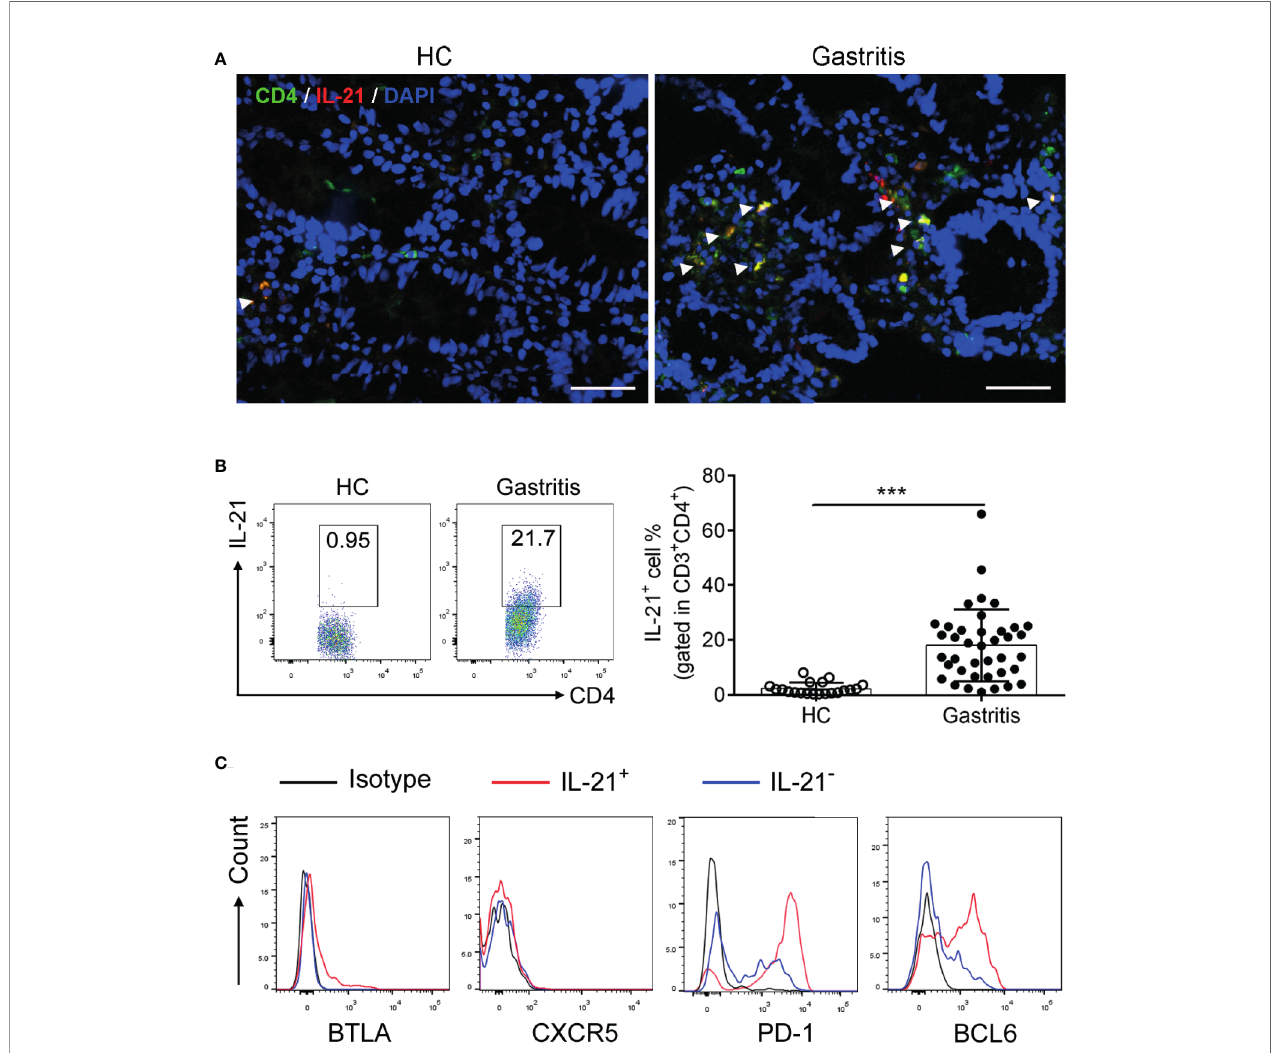
FIGURE 1 | Identi fi cation of IL-21 + TFH-like cells in Helicobacter pylori -positive gastritis. The biopsy specimens of gastric mucosa from H. pylori -positive patients ( n = 39) and healthy controls ( n = 20) were collected. (A) Immuno fl uorescence was conducted to determine the co-localization of CD4 (green) with IL-21 (red). The nucleus was stained with DAPI (blue). Scale bar: 100 µm. (B) The percentage of IL-21 + CD4 + T cells in the gastric mucosa was detected by fl ow cytometry. (C) The expression of BTLA, CXCR5, PD-1, and BCL6 in IL-21 + or IL-21 - CD4 + T cells was assessed by fl ow cytometry. Unpaired Student ’ s t -test was performed to determine the difference between two groups. Data represent mean ± SD from at least three independent experiments. *** P <